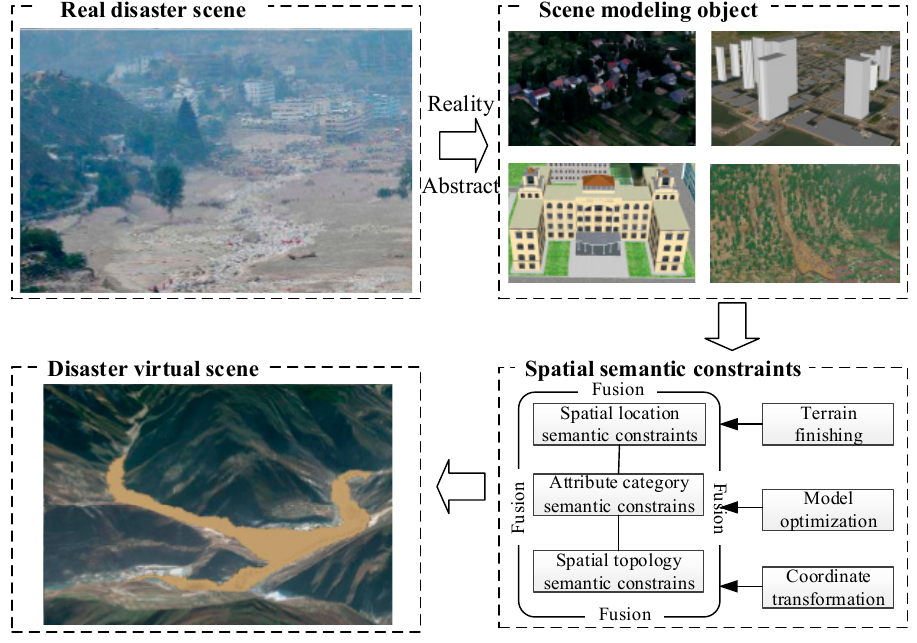
Figure 4. Spatial semantic constraints fusion visualization process.